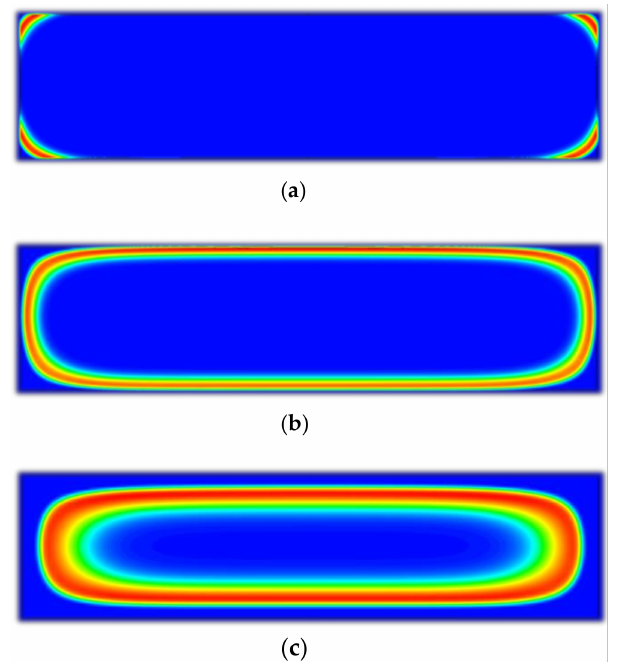
Figure 16. Concentration of “active” cellulose at ( a ) t = 15 s, ( b ) 25 s and ( c ) 35